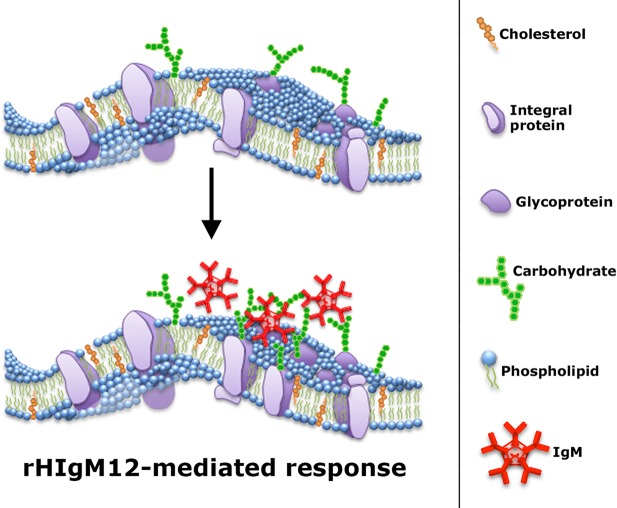
Working model of a potential rHIgM12 mechanism of action. Complex gangliosides, including GD1a and GT1b, are present in the plasma membrane anchored by their ceramide tails. The external carbohydrate moieties protrude into the extracellular space and can function as receptors for ligands, including rHIgM12. Each pentameric IgM contains ten potential binding sites. rHIgM12 binding to multiple sites on the plasma membrane could cluster ganglioside-rich membrane microdomains into larger complexes. The clustering of microdomain-associated molecules to a critical level triggers changes on the cytoplasmic face of the membrane, signaling the cell to respond.